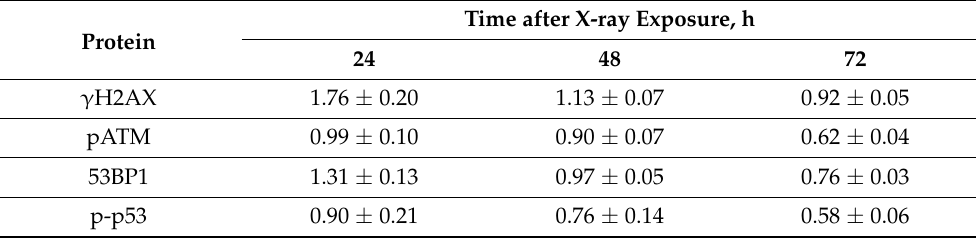
Table A1. The yield of residual foci of DNA damage response proteins per unit of absorbed dose (foci/cell/Gy) 24, 48 and 72 h after X-ray exposure.